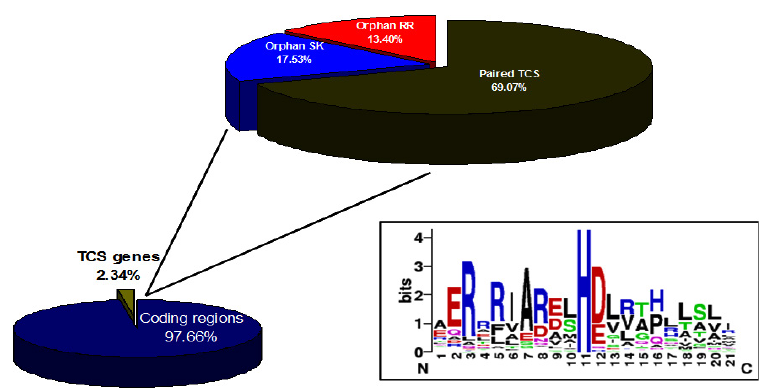
Fig. 2. Distribution of Two-component systems in genome of S. coelicolor . Box showing the highly conserved histidine. (http://www.p2cs.org)